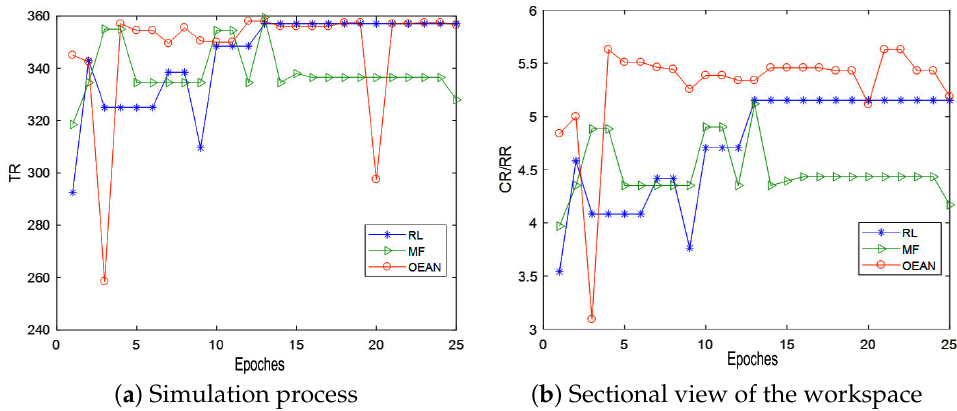
Figure 3. Performance indies of test process during the learning process. ( a ) is the total reward of the three methods. ( b ) is the ration of the ratio of CR to RR. As we can find out, the convergent tendency of the three methods is obvious in the two sub-figures. The TR is increased with the training process of the three method, and HMRF obtain best TR and the performance of the top-coal caving.